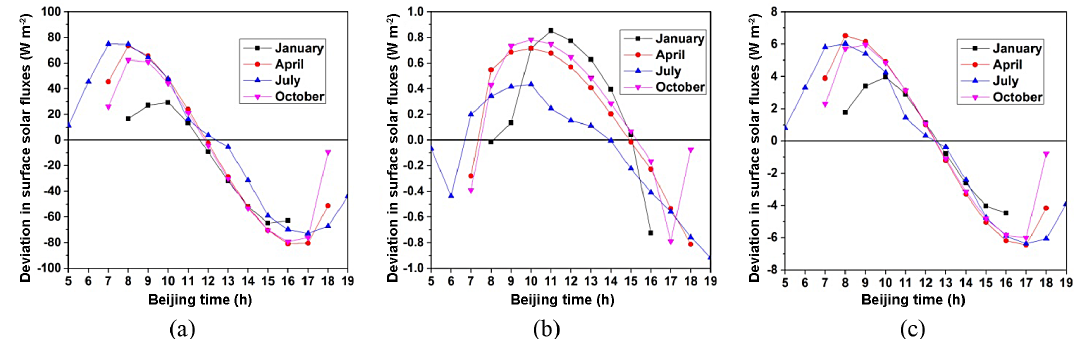
Figure 4. Diurnal variation of surface solar flux deviations between the 3-D radiation parameterization and the plane-parallel scheme in clear-sky condition without aerosols in typical grids marked by black bold rectangles in Fig. 1: (a) a typical mountainous area, defined as rectangle A; (b) a typical urban area in Domain 1, defined as rectangle B; (c) a typical urban area in Domain 2, defined as rectangle